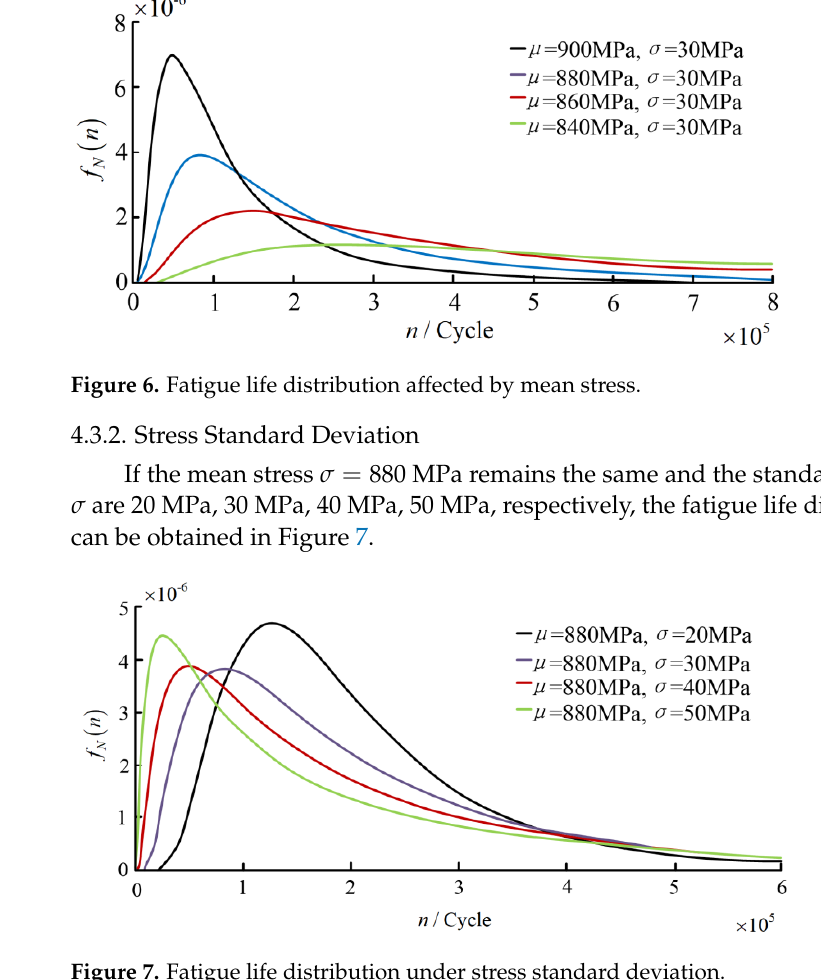
Figure 7. Fatigue life distribution under stress standard deviation.